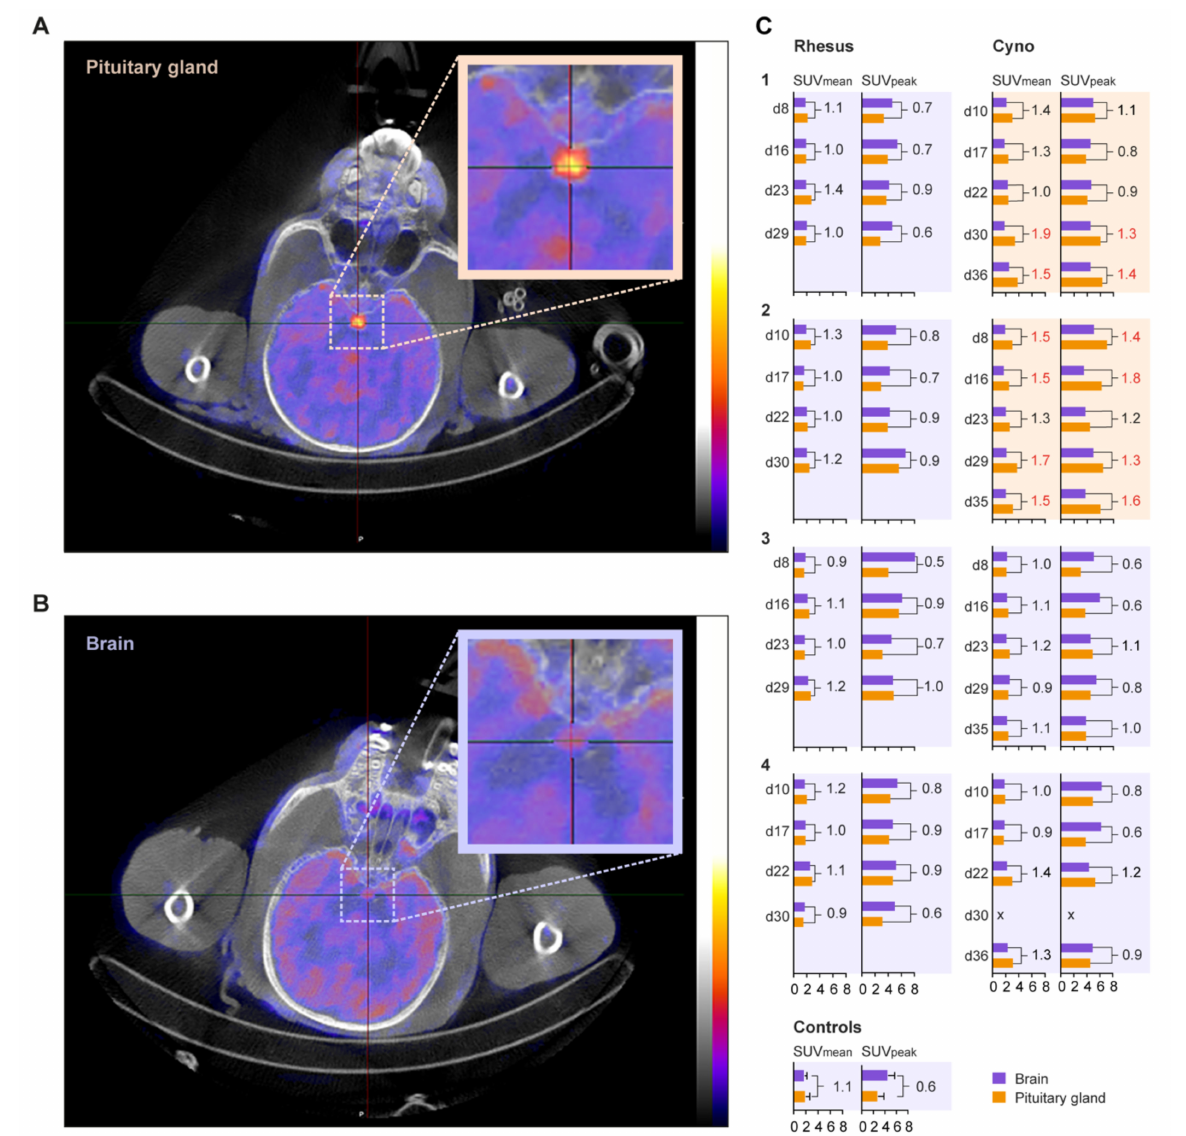
Figure 1. 18 F-FDG uptake in the pituitary gland after SARS-CoV-2 infection. Representative transver- sal slices of cynomolgus macaque C2, with increased 18 F-FDG uptake in the pituitary gland, ( A ) and C3, with normal pituitary 18 F-FDG uptake, ( B ) on day 8 are shown. The pituitary gland is indicated by the cross-hairs and boxed. Similar window-level settings are applied for both sections. ( C ) The standardized uptake values (SUV) of the brain and pituitary gland of each animal, per timepoint, are shown. On the Y -axis, the day post-infection of PET-CT and on the X -axis the SUV of the brain (purple bars) and pituitary gland (orange bars) are visualized for rhesus (left column) and cynomolgus (right column) macaques. For each animal, the SUV mean and SUV peak are shown. The numbers in the graph represent the ratio of the SUV for the pituitary gland value divided by the SUV of the brain. A deviation from normal is defined as SUV mean ratio ≥ 1.5 and SUV peak ratio ≥ 1. These ratios are indicated in red. Six non-infected animals were used as control for the definition of normal pituitary gland and brain SUVs. The animals boxed with an orange background showed increased uptake in the pituitary gland, while the animals boxed with a purple background do not show this